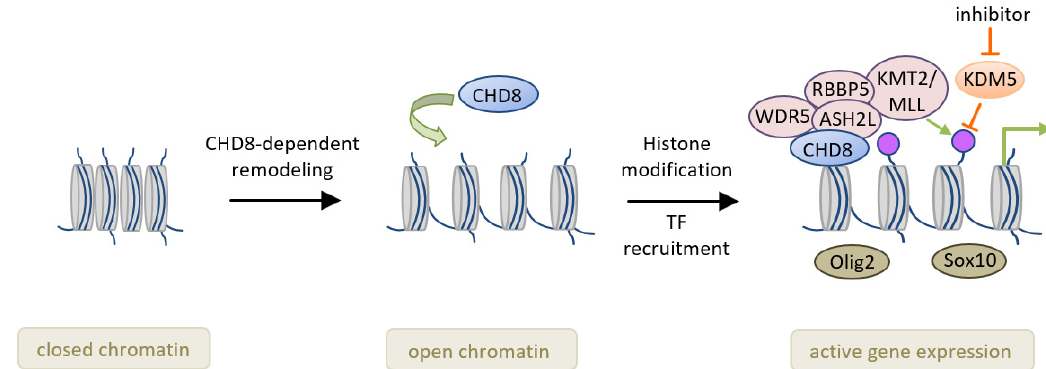
Figure 3. Schematic model for the role of CHD8 in oligodendrocyte development. Closed chromatin in oligodendrocyte precursors cells prevents transcription ( left ). Upon binding, CHD8 remodels chromatin into an open state ( middle ). This process provides access to lineage-specific transcription factors such as the oligodendrocyte factors Olig2 and Sox10. Following binding to their sequence-specific DNA-elements, these factors drive expression of target genes important to the progression of oligodendrocyte development. Concurrently, CHD8 recruits the histone methyltransferase complex KMT2 that catalyzes histone 3 lysine 4 trimethylation (violet dots) that flags actively transcribed and poised gene promoters. Inhibition of the KDM5 subfamily of histone demethylases partially compensates differentiation defects in Chd8 null mice ( right ). Schematic adapted from [41], attribution license 4838110791658.